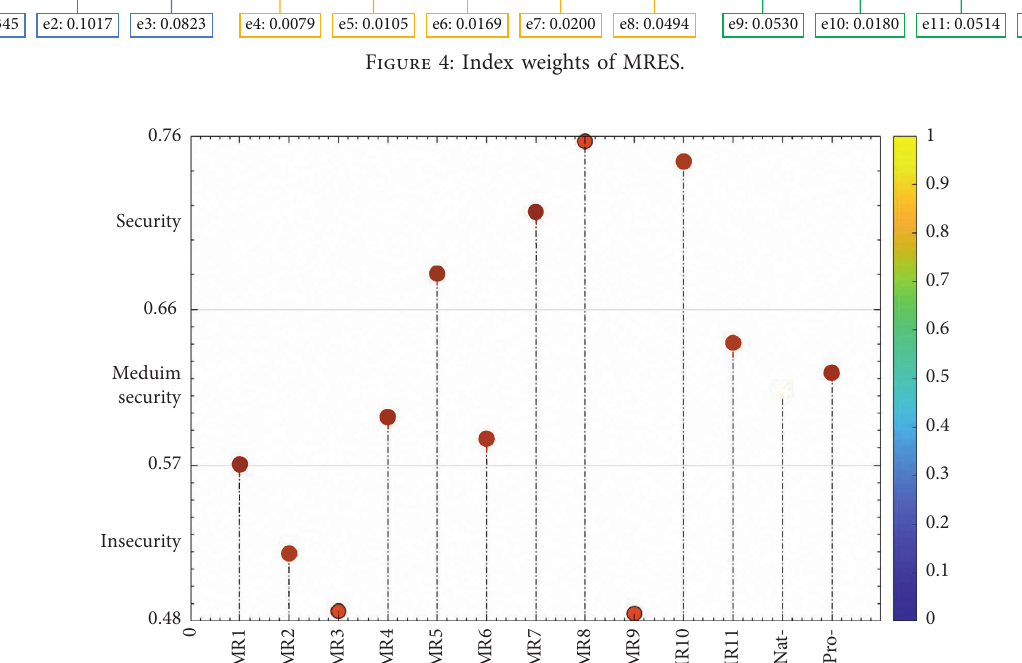
Figure 5: MRES evaluation values for marine ranches in